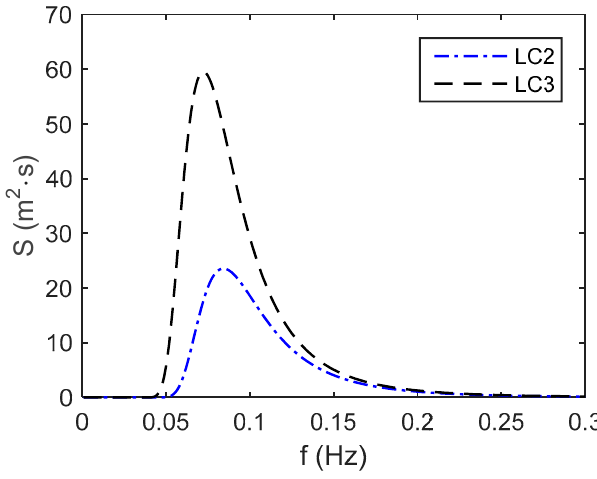
Figure 8. Pierson-Moskowitz wave spectra for LC2 and LC3.